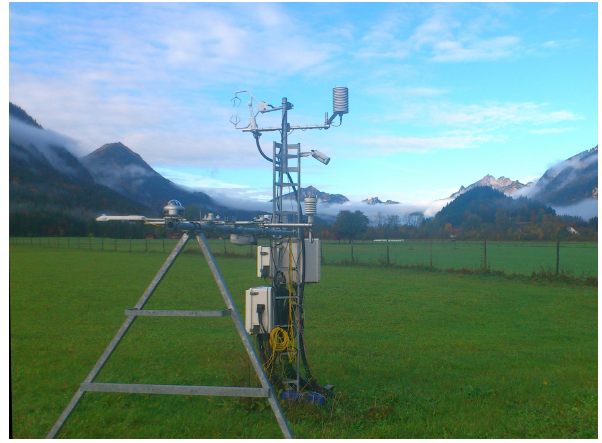
Figure 5. Photograph of the eddy-covariance system at DE-Gwg grassland site. The mountains in the background are up to 1000m higher than the grassland in the foreground (photograph by Matthias